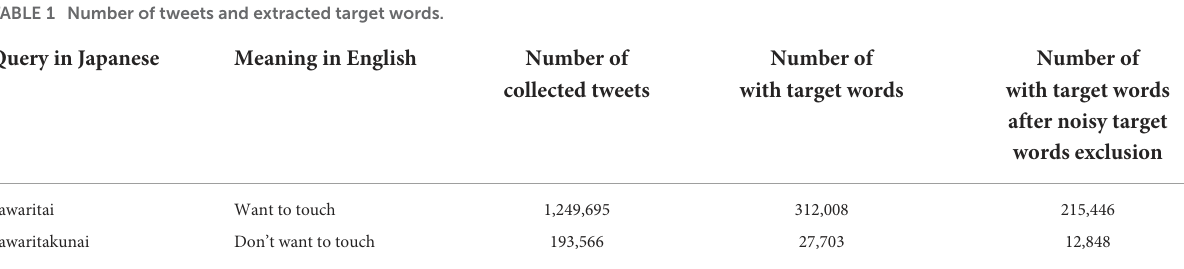
Number of with target words